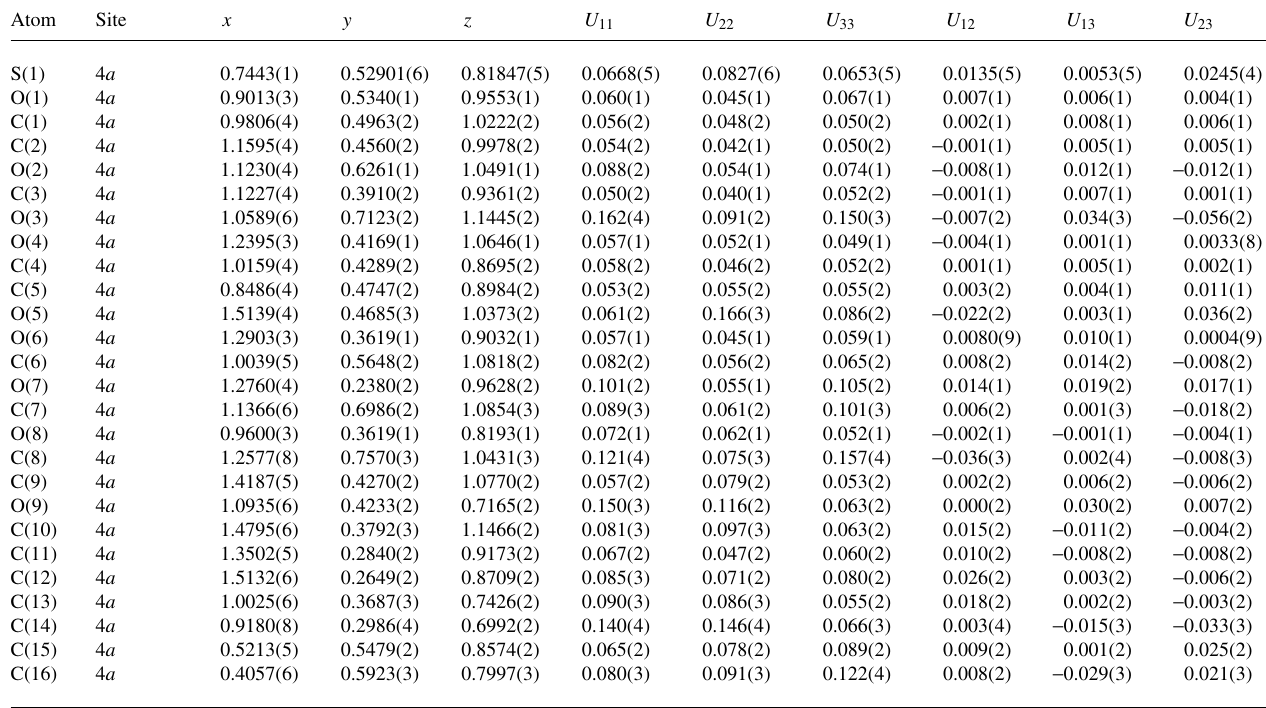
Table 3. Atomic coordinates and displacement parameters (in Å 2 )